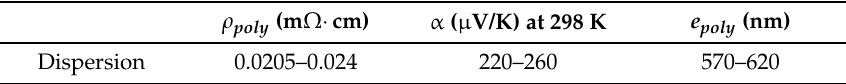
Table 1. Range of values for electrical resistivity ρ poly , thermoelectric coefficient α and thickness e poly of the polysilicon layer.